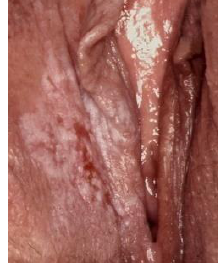
Figure 6. Paget’s disease.